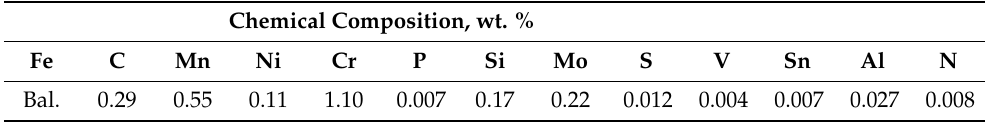
Table 1. The chemical composition of the investigated steel. Chemical Composition, wt.